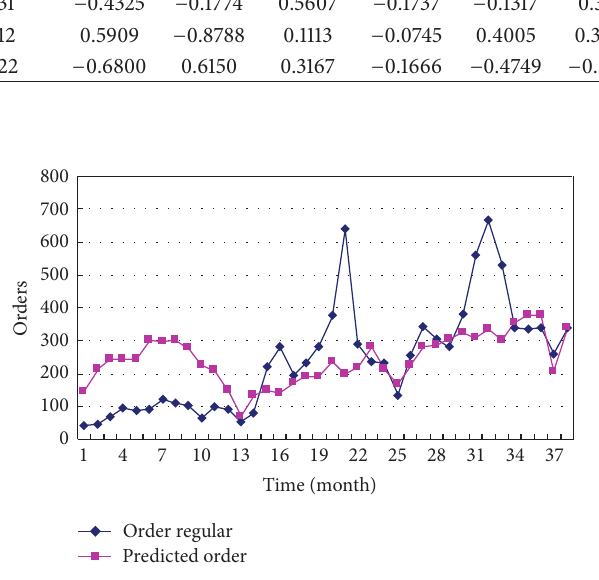
Figure 5: Simple linear regression of the regular orders and national import & export.